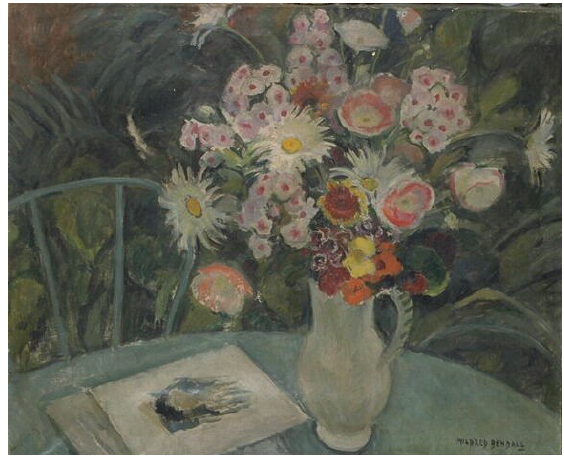
Figure 13. Mildred Bendall (1891–1977), Vase de fleurs , c. 1937, oil on canvas, 60 cm × 73 cm, Bordeaux, musée des beaux-arts, BX E